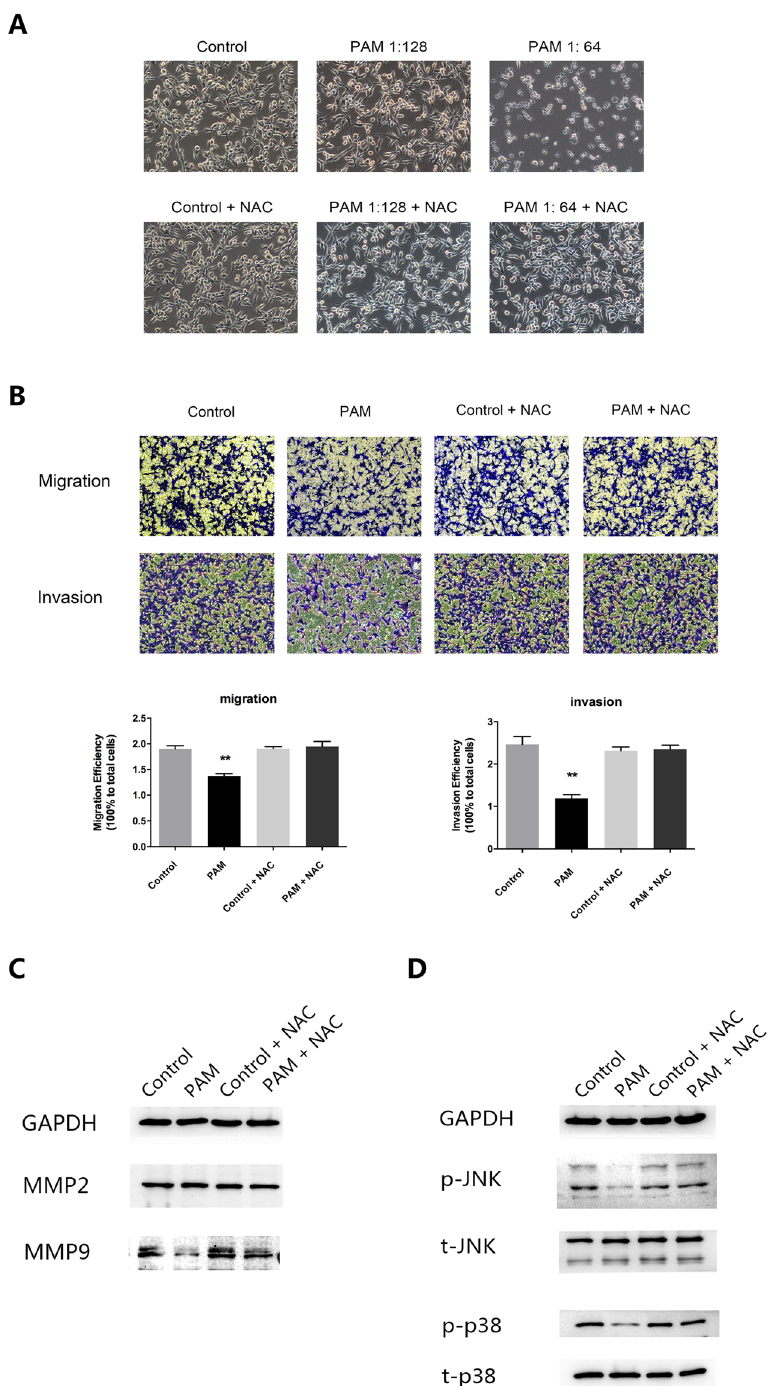
Figure 6. Anti-metastatic effect of PAM is antagonized by the ROS scavenger. Diluted PAM wsa incubated with NAC (4 mM, Sigma-Aldrich, St. Louis, MO, USA) at room temperature for 30 min before the following treatments. ( A ) Morphological changes of ES2 cells after PAM treatment together with or without NAC. ( B ) Cell migration and invasion analysis of ES2 cells by transwell assay. Both migration and invasion ability were calculated in comparison to the total seeded cells. ( C ) Protein expressions of MMP-9 and MMP-2 in ES2 cells after PAM with or without NAC treatment. ( D ) Protein expressions of both phosphorylated and total level of MAPK pathway components, JNK1/2 and p38. GAPDH was chosen as an internal reference. The original full-length blots are presented in Supplementary Figure 3. In transwell assay, three representative fields of cells in each group were captured and calculated, while one was chosen for presentation in this study. Data were presented as means ± SD. Three independent experiments were performed. Statistics were shown as * P < 0.05; ** P <